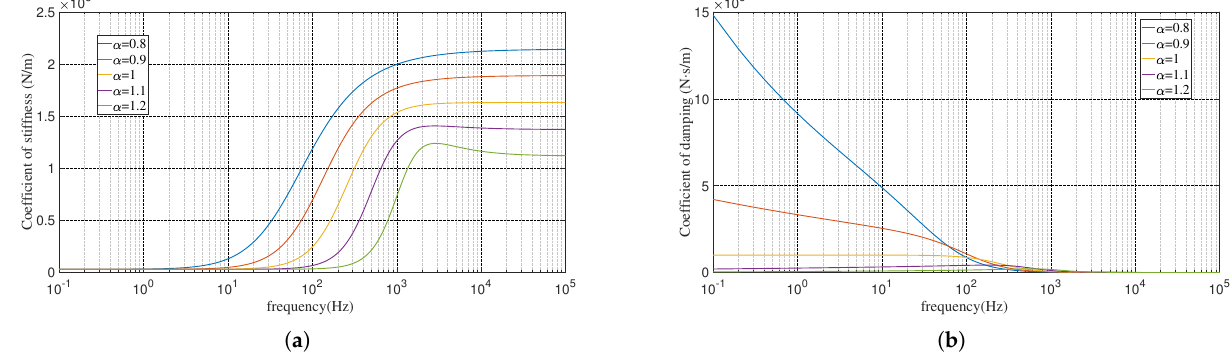
Figure 9. Effect of the fractional order on dynamic characteristics of the FOZGF model. ( a ) Change of dynamic stiffness with the α order. ( b ) Change of damping with the α